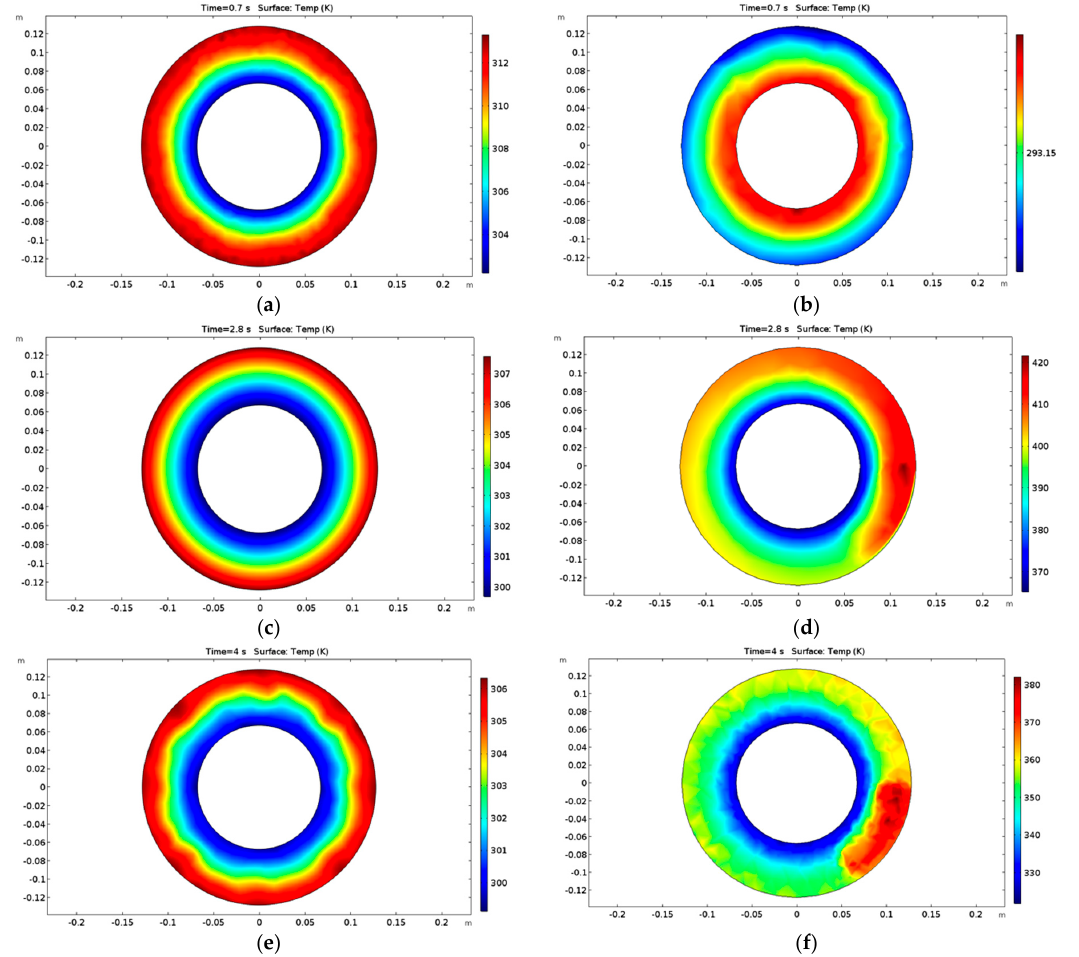
Figure 5. Cloud charts of temperature distribution of integrated brake disc. ( a ) Electromagnetic brake surface at 0.7s; ( b ) Friction brake surface at 0.7s; ( c ) Electromagnetic brake surface at 2.8s; ( d ) Friction surface at 0.7 s; ( b ) Friction brake surface at 0.7 s; ( c ) Electromagnetic brake surface at 2.8 s; ( d ) Friction brake surface at 2.8s; ( e ) Electromagnetic brake surface at 4.0s; ( f ) Friction brake surface at 4.0s. brake surface at 2.8 s; ( e ) Electromagnetic brake surface at 4.0 s; ( f ) Friction brake surface at 4.0